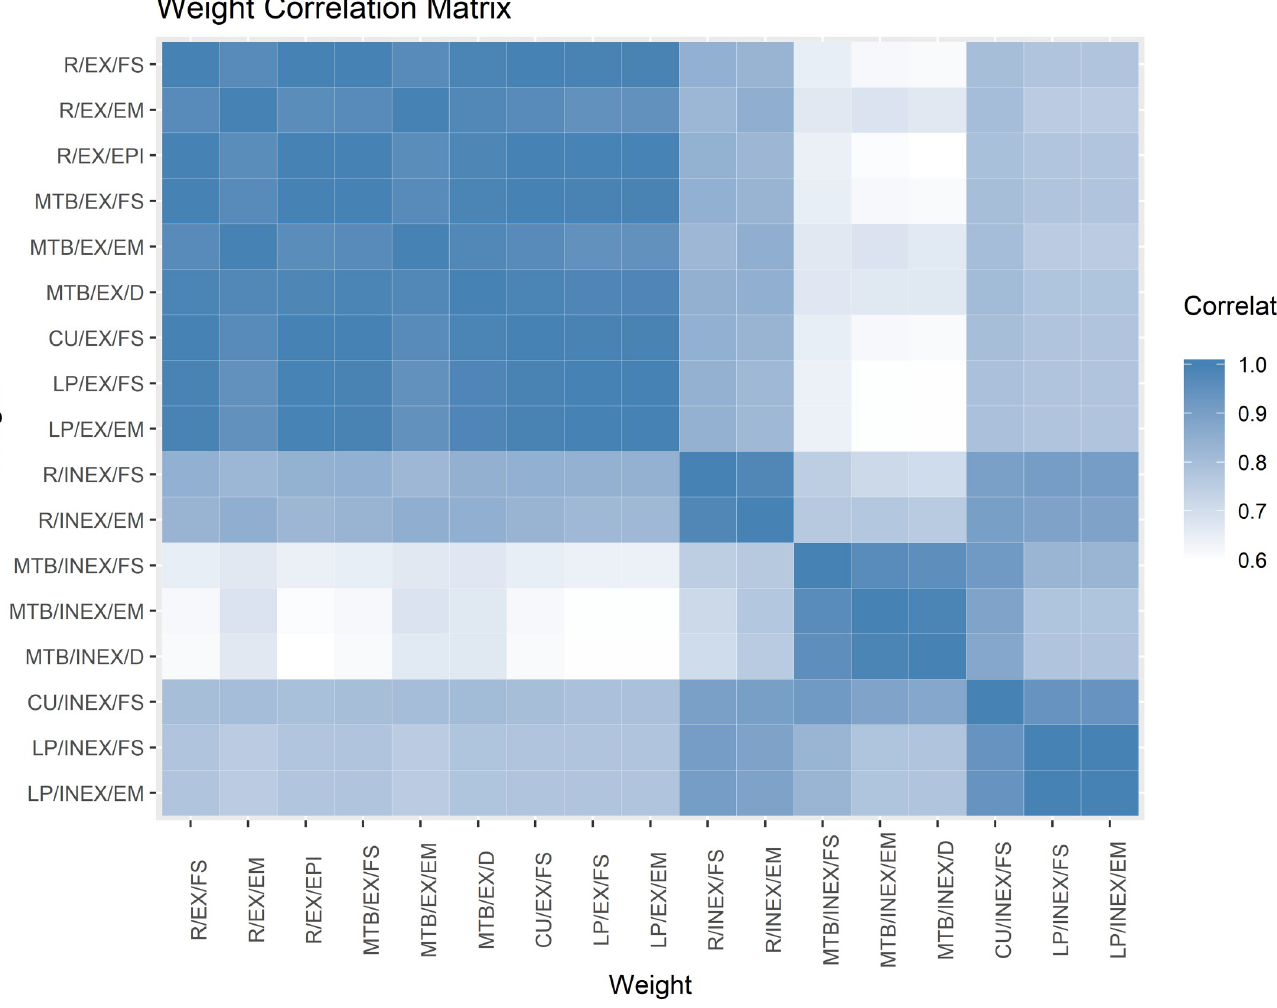
Fig 1. Correlation matrix for the 17 sets of weights. EX, exact string matching; INEX, inexact string matching; R, R package; MTB, Merge ToolBox; CU, Curtin University Probabilistic Linkage Engine; LP, Link Plus; FS, probabilistic, Fellegi-Sunter; EM, probabilistic, expectation-maximization; EPI, probabilistic, EpiLink; D, deterministic. The rows and columns are ordered so that runs using exact methods are at the top and